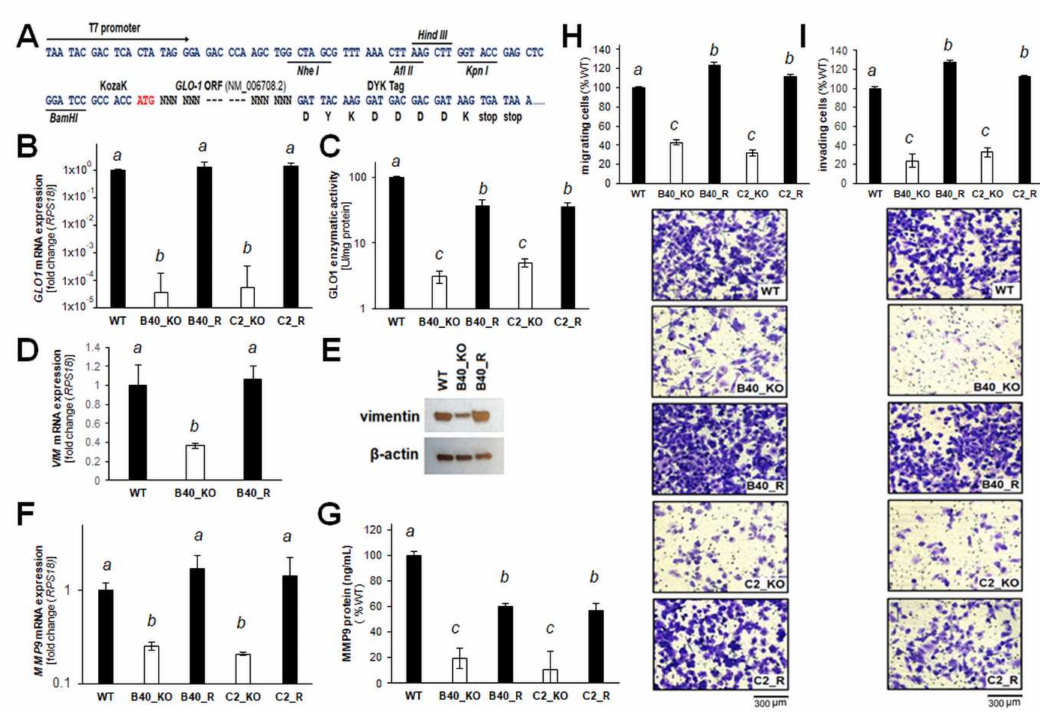
Figure 6. CMV-driven GLO1 re-expression (A375- GLO1 _R) restores the migration and invasion potential of A375 malignant melanoma cells with genomic GLO1 deletion. ( A ) Insertion site of CMV-driven expression construct for stable transfection of A375- GLO1 _KO clones. ( B ) RT-qPCR analysis of GLO1 mRNA levels in A375 melanoma cell lines (WT, B40_KO, C2_KO, B40_R, and C2_R). ( C ) GLO1-specific enzymatic activity in A375 melanoma cell lines (WT, B40_KO, C2_KO, B40_R, and C2_R). ( D ) RT-qPCR and ( E ) immunoblot assessment of vimentin expression (WT, B40_KO, and B40_R). ( F ) RT-qPCR and ( G ) ELISA assessment of MMP9 expression (WT, B40_KO, and B40_R). ( H ) Transwell migration (WT, B40_KO, C2_KO, B40_R, and C2_R) and ( I ) invasion though Matrigel-coated Boyden chambers